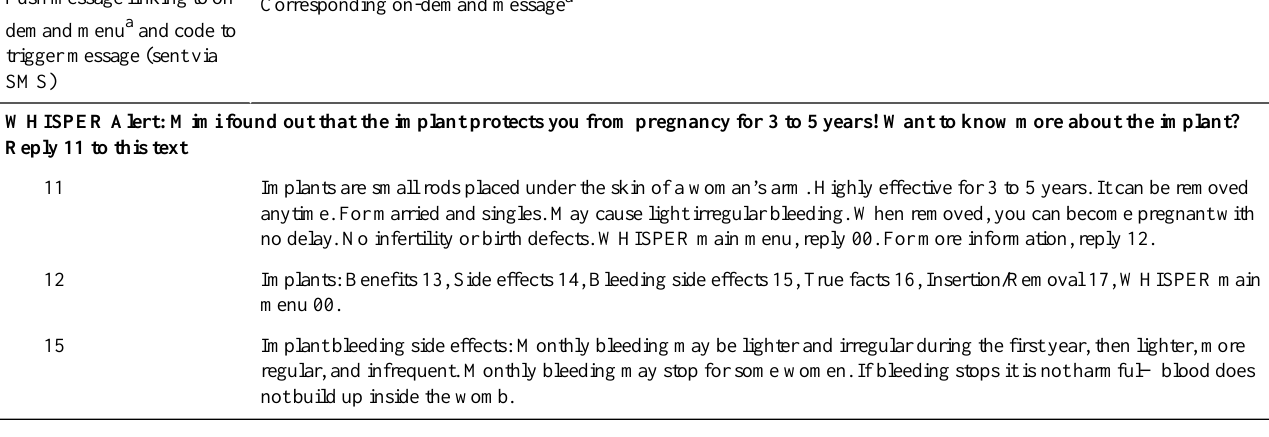
Table 3. Example message providing a link to on-demand content, SMS codes, and corresponding on-demand messages. Corresponding on-demand message a Push message linking to